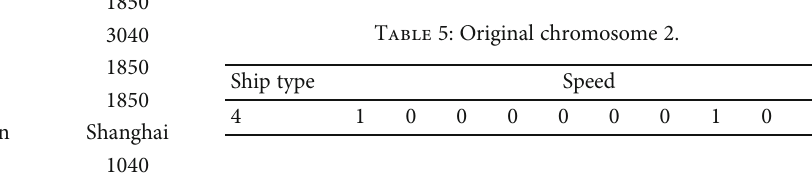
Table 6: New chromosome 1.